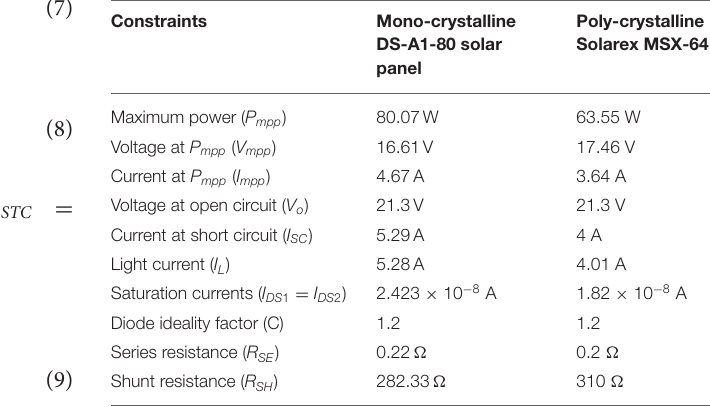
TABLE 3 | Estimated values of one-diode R SH